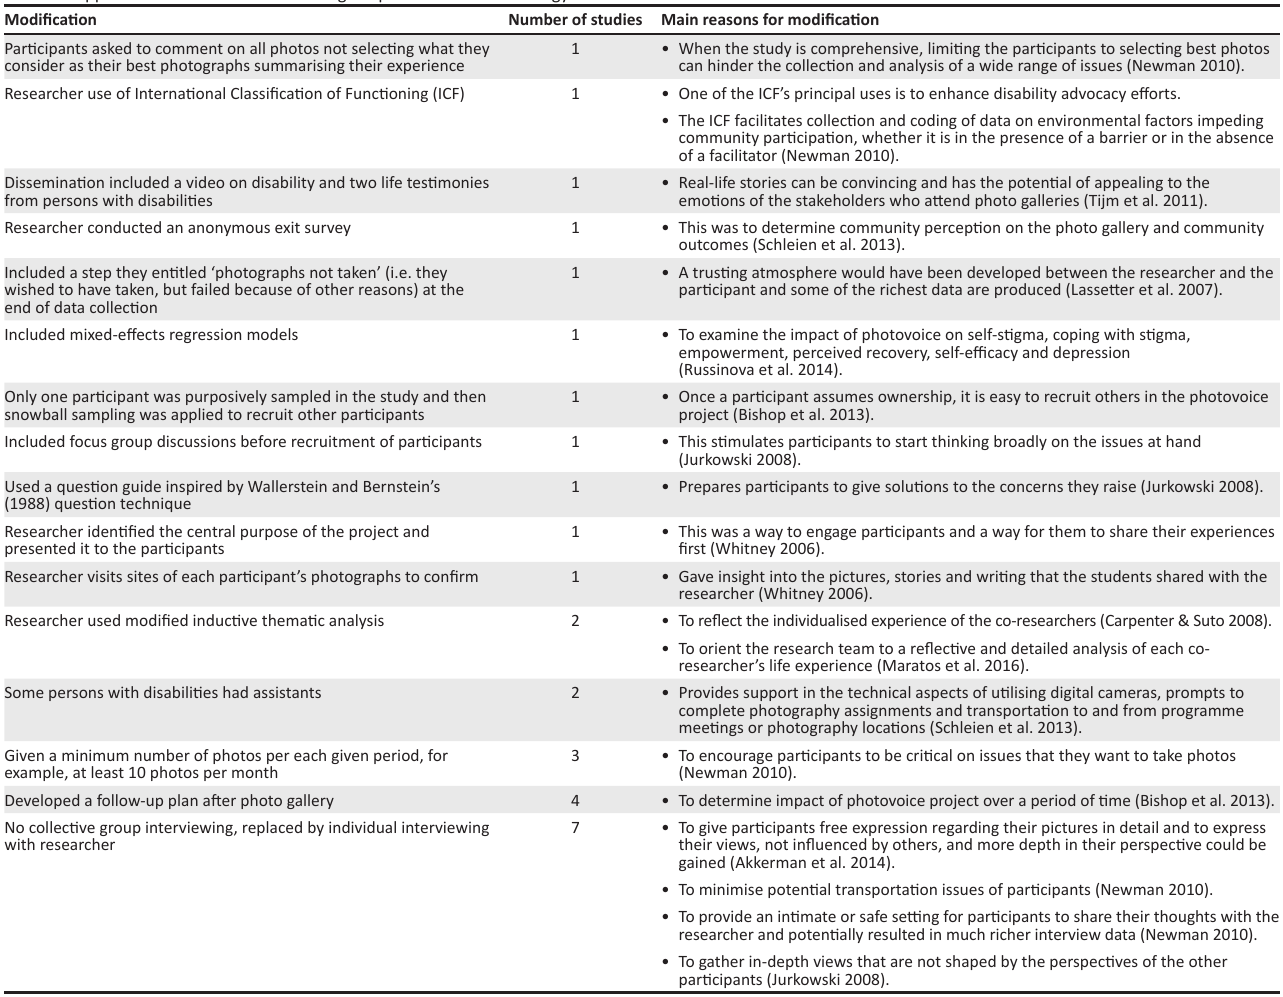
TABLE 2: Application and modification of original photovoice methodology.